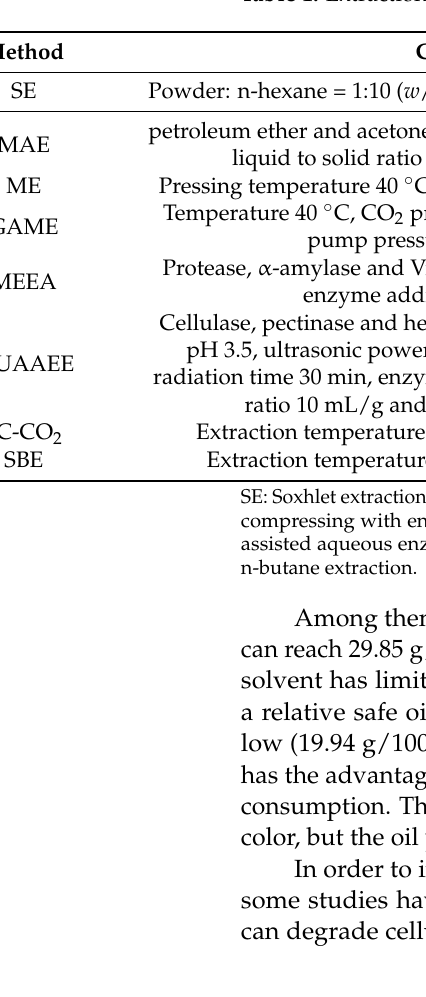
Table 1. Extraction technologies of tiger nut